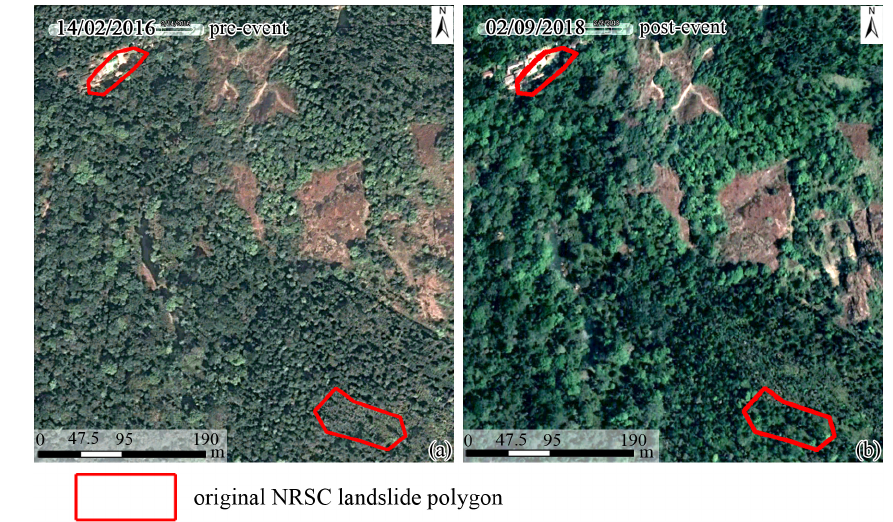
Figure 3. Examples of landslides in the NRSC inventory that were not considered as actual landslides after visual inspection. The examples in (a) and (b) show that there are no visible scarps before or after the event near the marked polygons. Basemap data © 2019